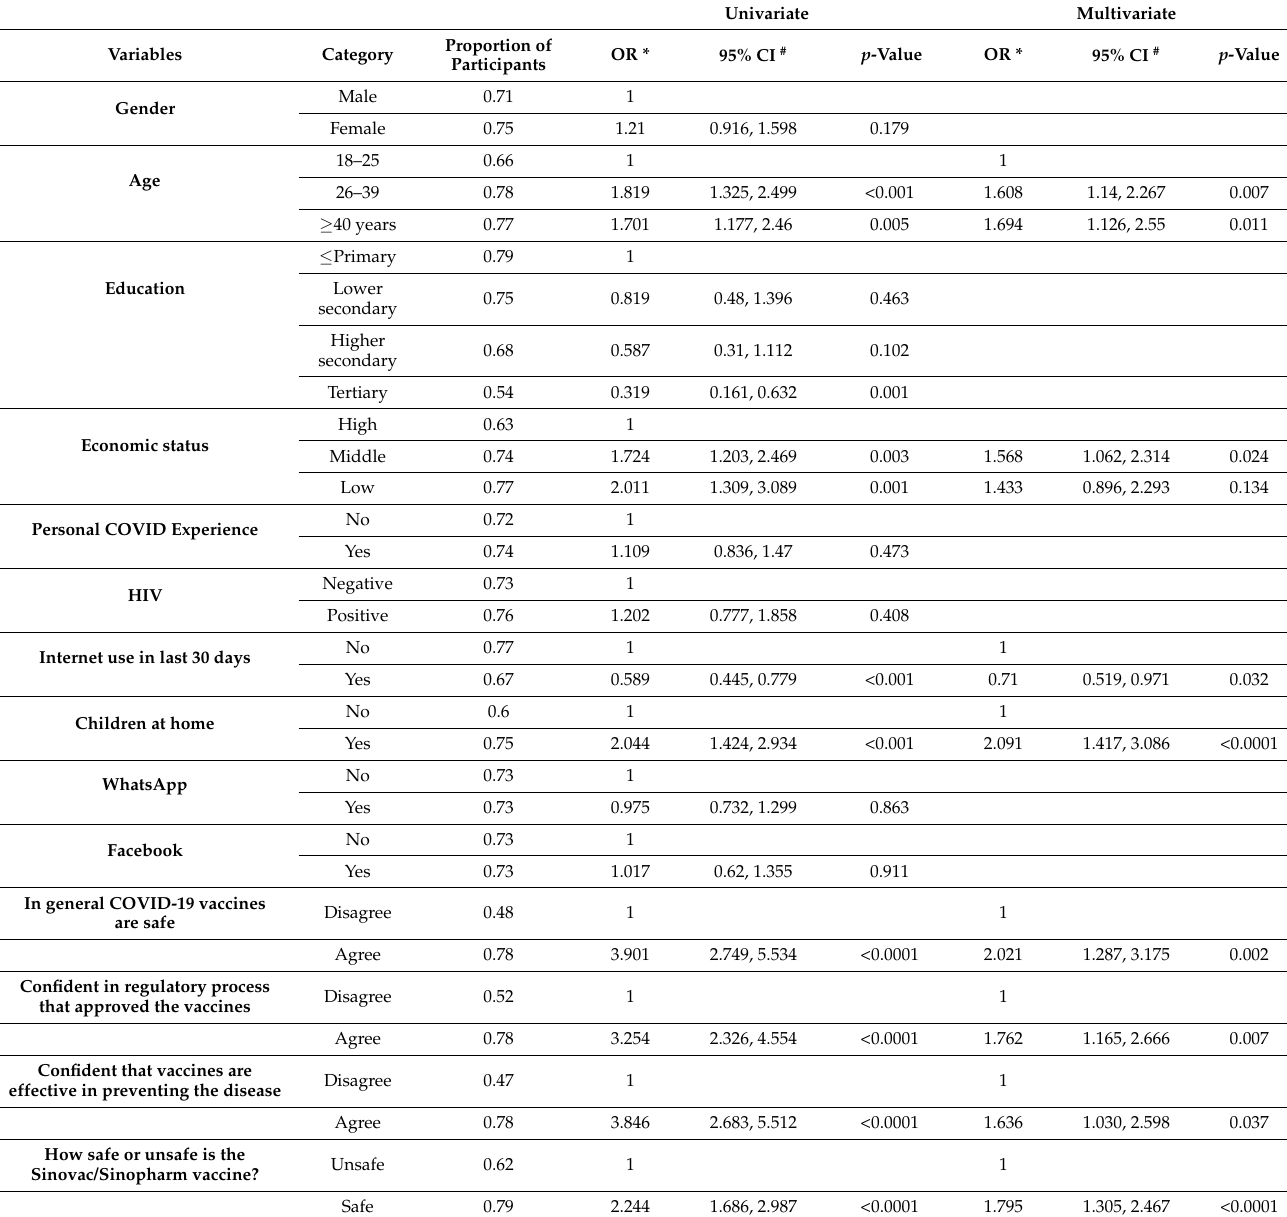
Table 6. If the COVID-19 vaccine was available to your child, how likely would you be to get your child vaccinated? (Extremely likely/Very